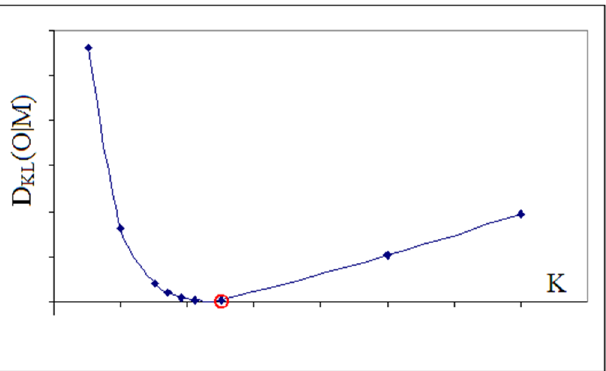
Figure 12. Determining the optimal value of coefficient K . The lowest D KL value is marked (red circle).